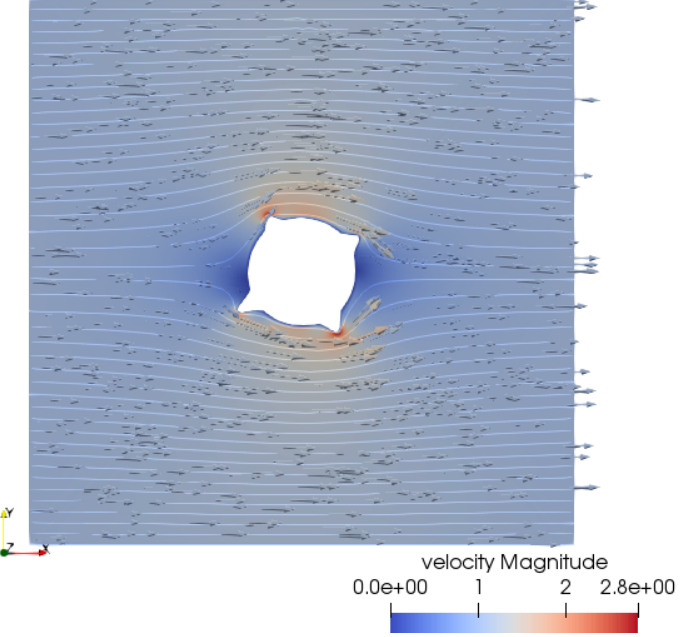
Figure 26. Case 5: the fluid shear stress representation, which is between − 2.8 and 2.5 dyn/cm 2 . ( a ) The fluid shear stress overview; ( b ) zoom over the higher shear stress zone.